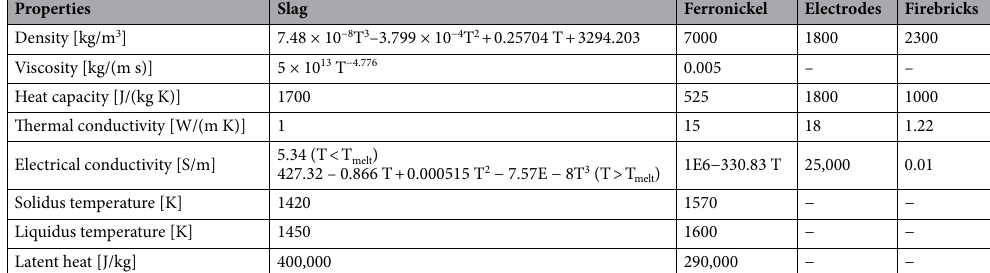
Table 1. Thermophysical properties of materials used in the computations. The slag properties were determined via MD simulations 21 while for the ferronickel, electrode and firebrick domains they were obtained from the literature 11,23–29 . A graphical representation of the density, viscosity and electrical conductivity is given in Appendix